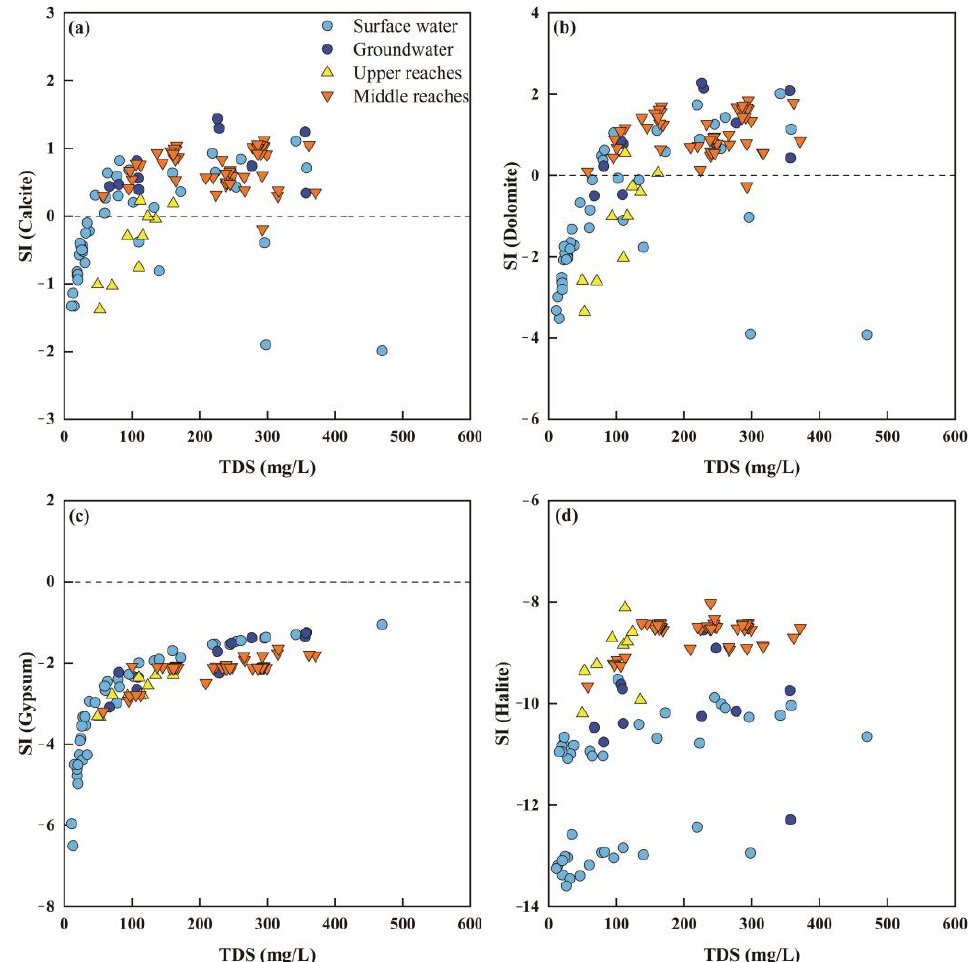
Figure 11. Relationship between saturation index (SI) of different minerals in surface water and groundwater and total dissolved solids (TDS). ( a ) SI (calcite); ( b ) SI (dolomite); ( c ) SI (gypsum), and ( d ) SI (halite). Data are from Tables 1 and 2.